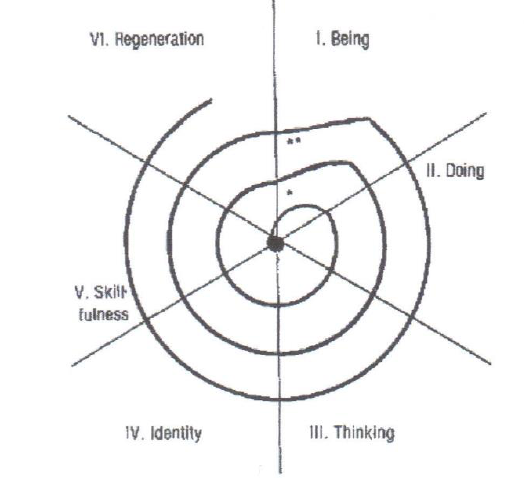
Figure 8: Major Phases (Levin 1982 p.